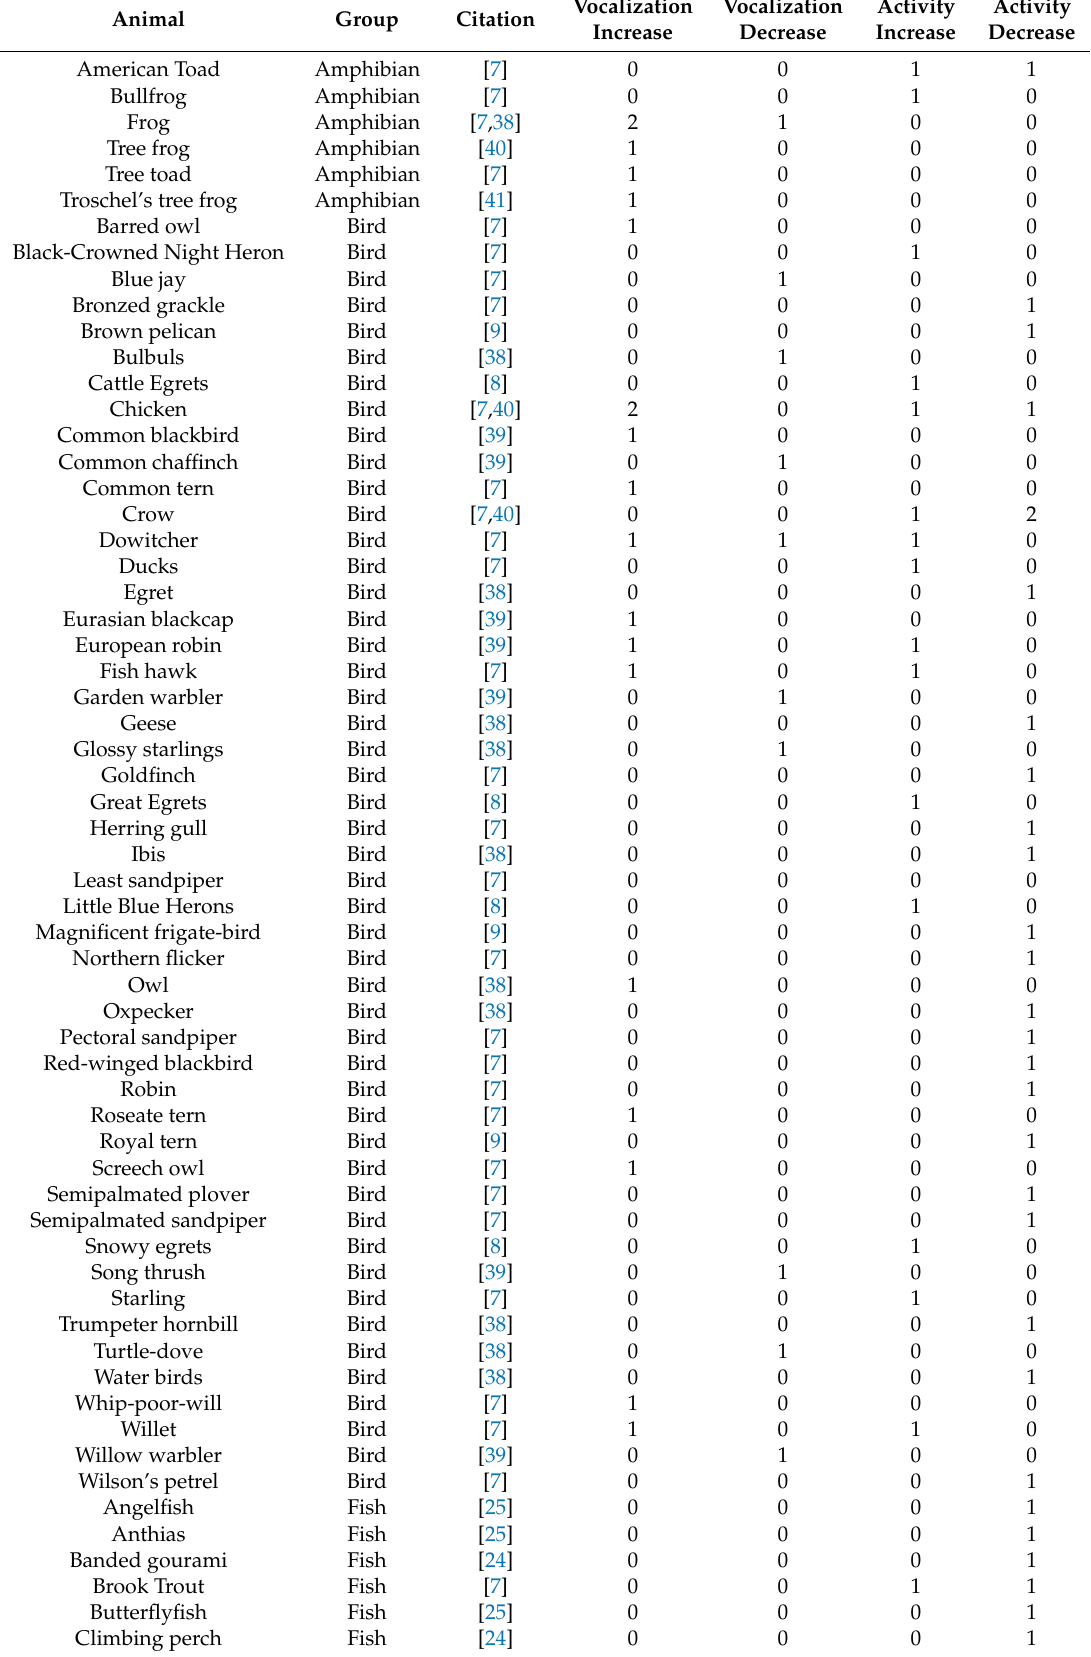
Table 2. Total number of observations reporting changes in animal behavior during eclipses enumerated from published